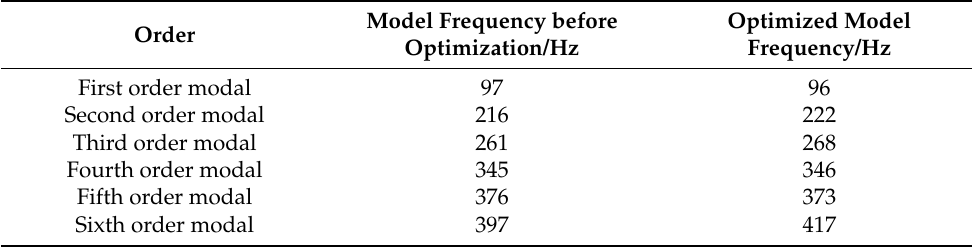
Table 8. Comparison of free modal analysis results before and after optimization of aluminium alloy front